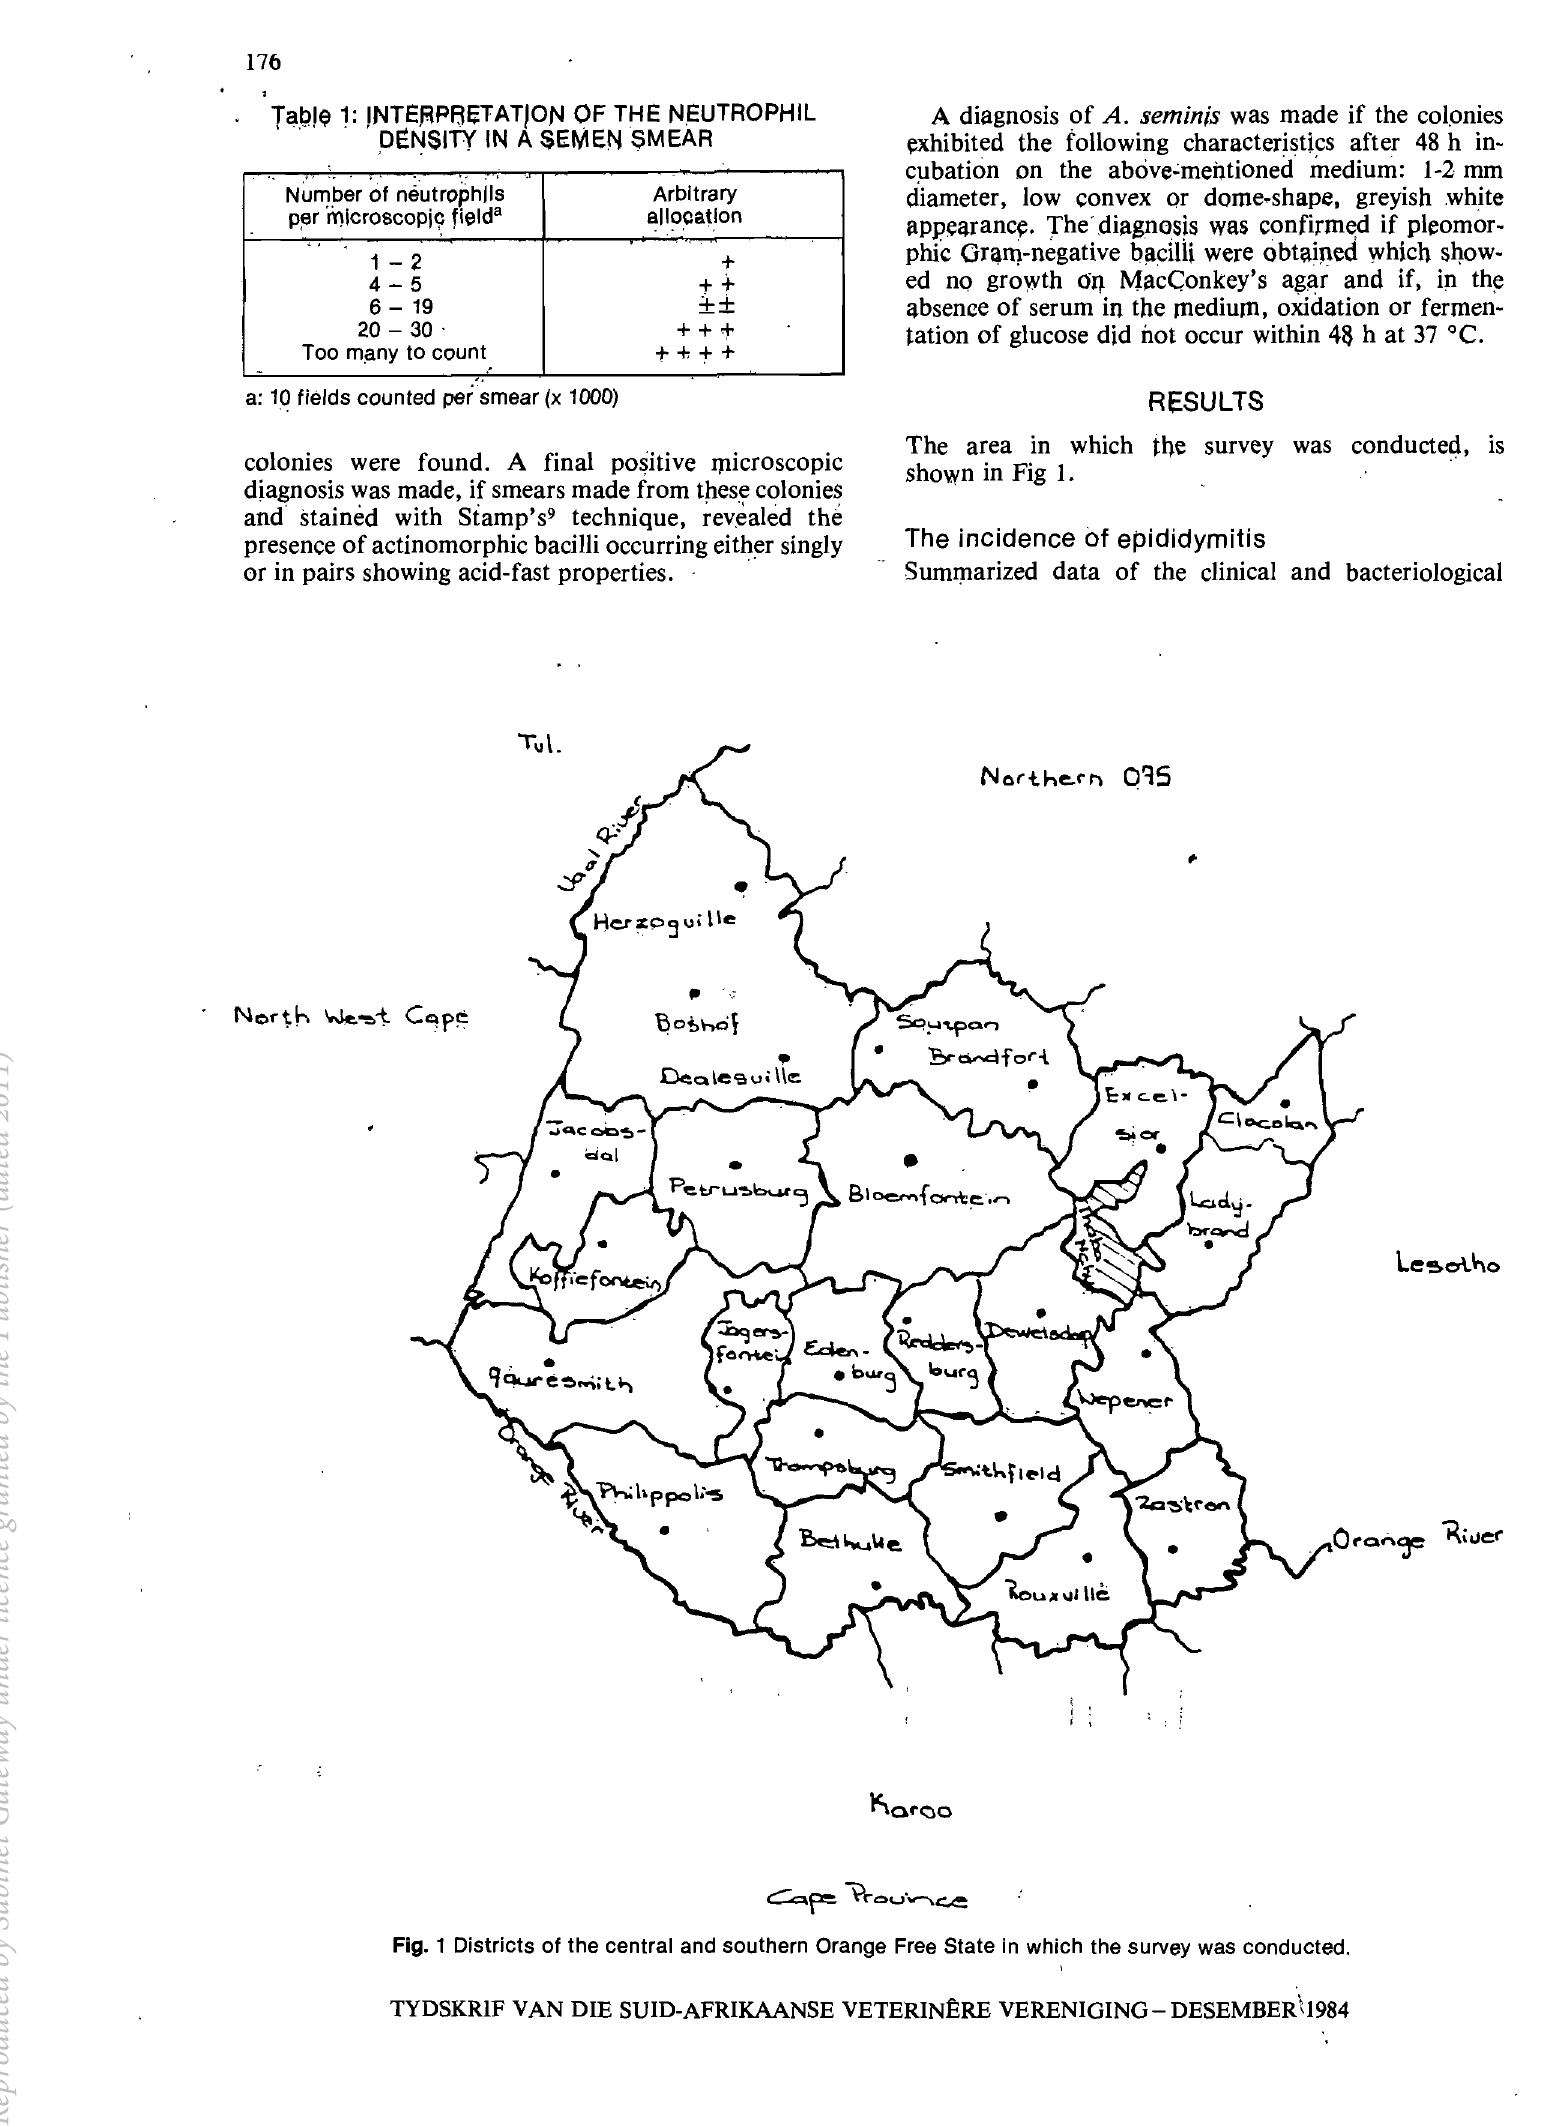
Fig. 1 Districts of the central and southern Orange Free State in which the survey was conducted. TYDSKRIF VAN DIE SUID-AFRlKAANSE VETERINERE